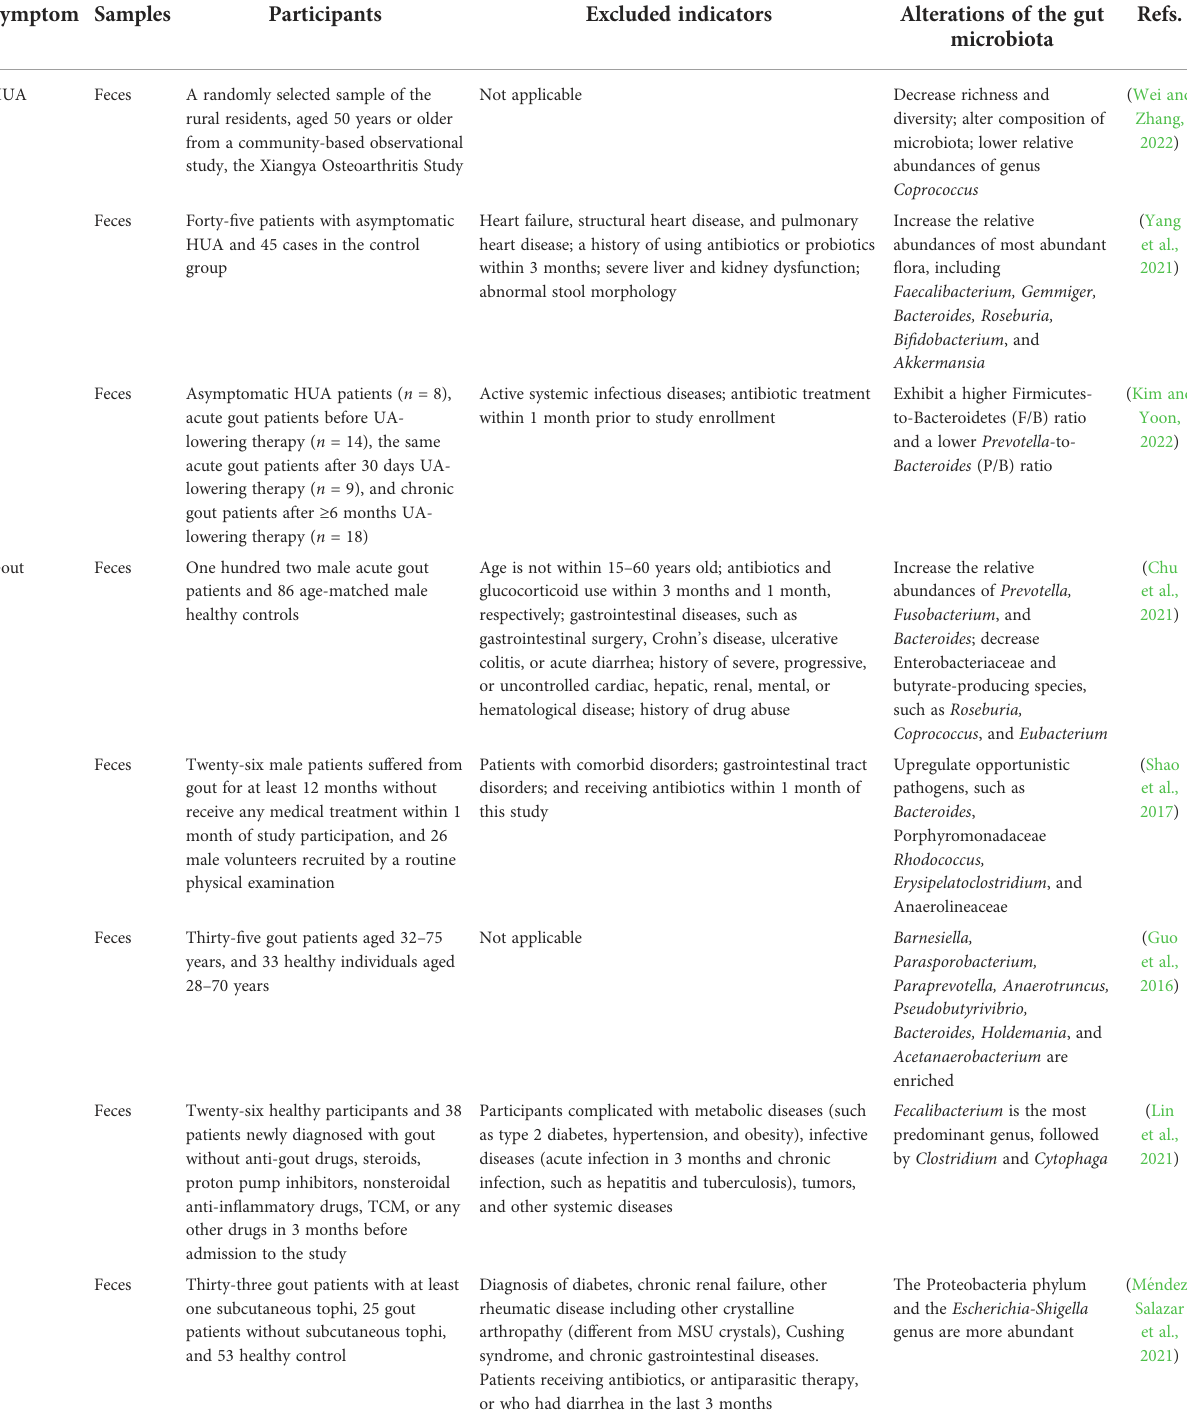
TABLE 1 Gut microbiota changes in patients with hyperuricemia and